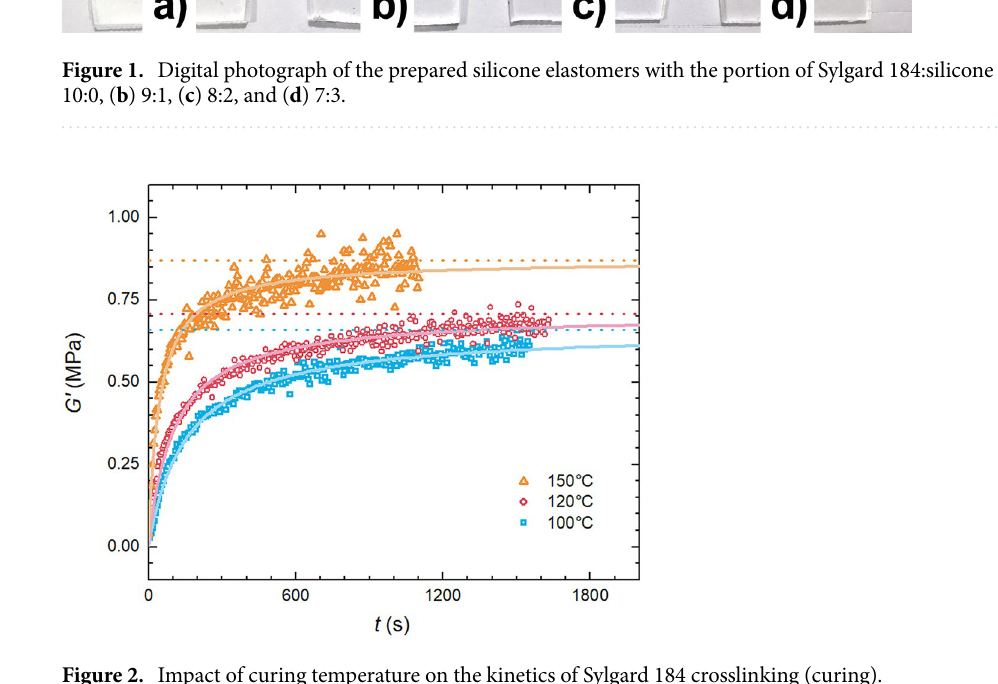
Figure 2. Impact of curing temperature on the kinetics of Sylgard 184 crosslinking